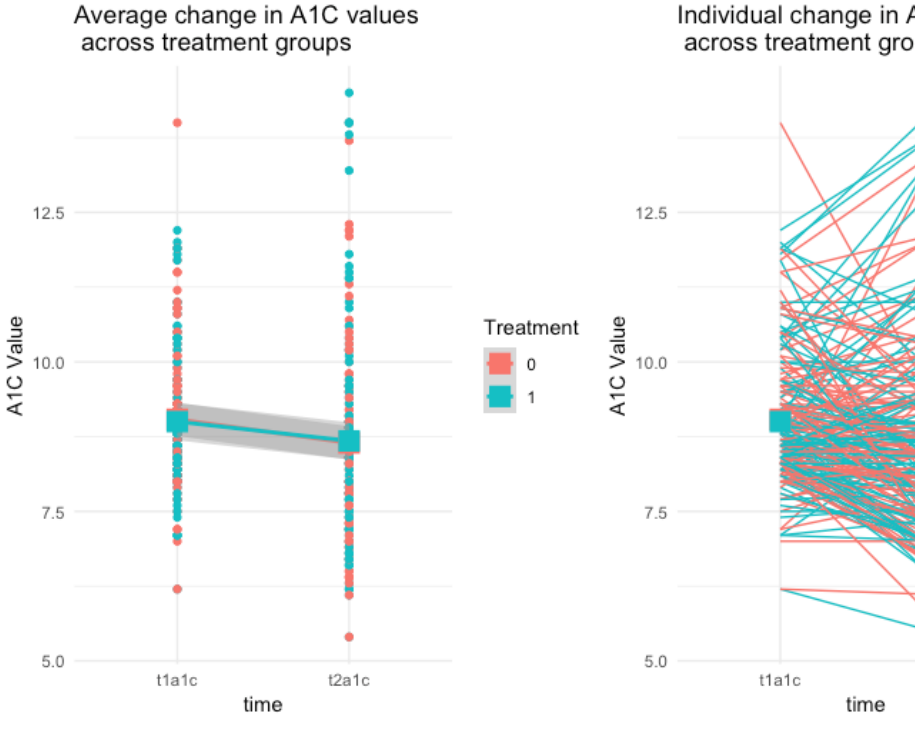
Figure 1. Average individual change in hemoglobin A1c (A1C) by